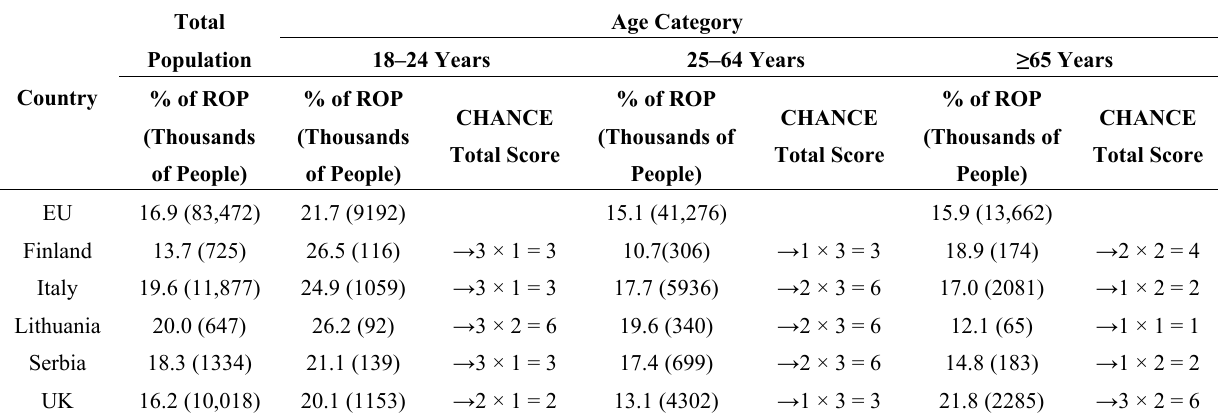
Table 4. At-risk-of poverty rate (% of ROP, with thousands of people in parentheses) and calculations of the CHANCE total score. Selected data from EUROSTAT 2011 [6] for all countries except Serbia in 2010